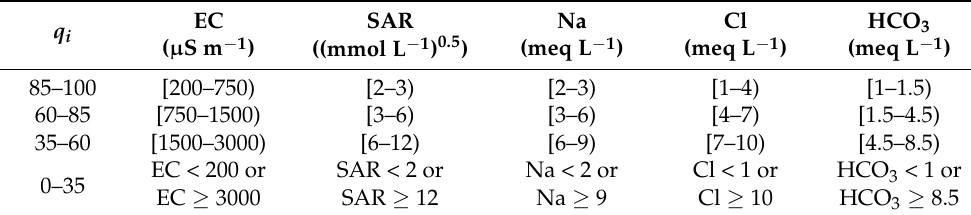
Table 1. Irrigation water quality parameters and their proposed limiting